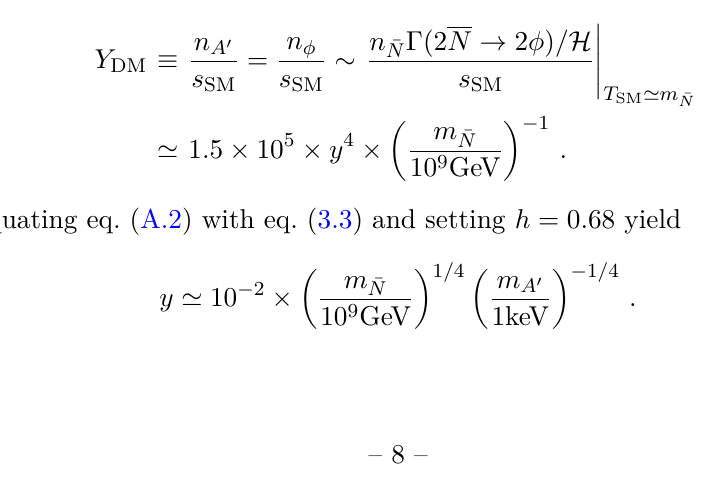
Figure 2 . The constraints on the parameter space of ( λ, m φ ) which is consistent with the conditions (1a), (2a), (3a’) and (1b) presented in eq. (2.2), eq. (2.3), eq. (3.5), eq. (3.2) (yellow shaded region) and τ A 0 & 13 . 8Gyr (the region above the blue dashed line). Along the green dashed line, A 0 can explain the current DM abundance. The values shown in (a) being fiducial, each plot of (b), (c) and (d) results from variation of one of ( m A 0 , T RH , m ¯ satisfy [7,